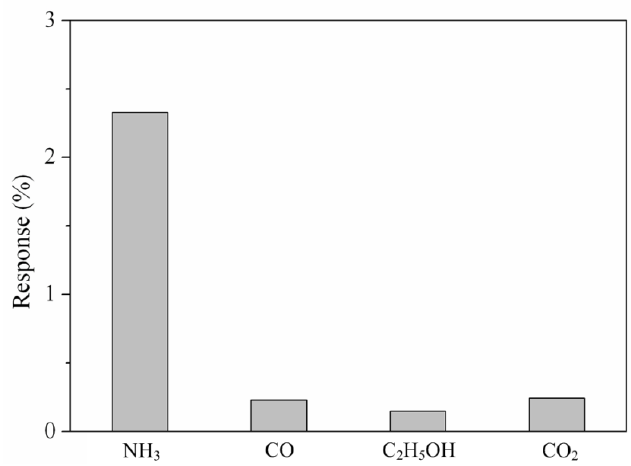
Figure 9. Response of the sensor to different gases.